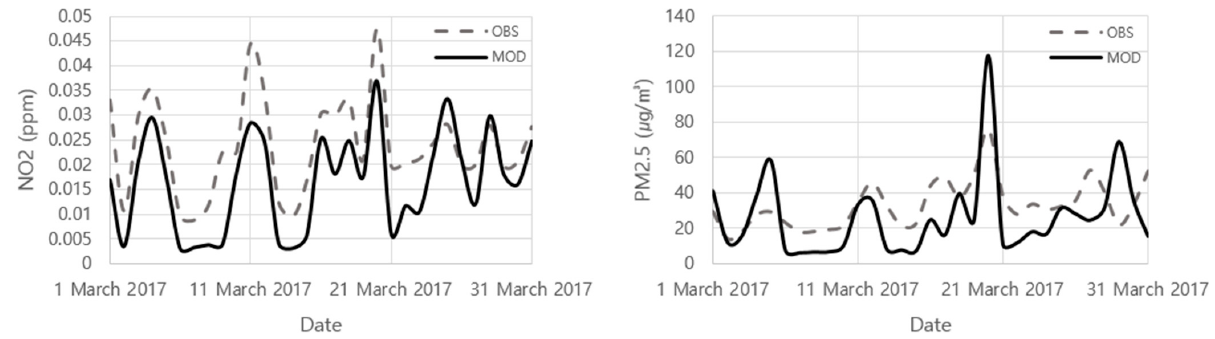
Figure 2. Time Series Plots of Model and Observation Data.